Question: Give a one-sentence summary of this figure.
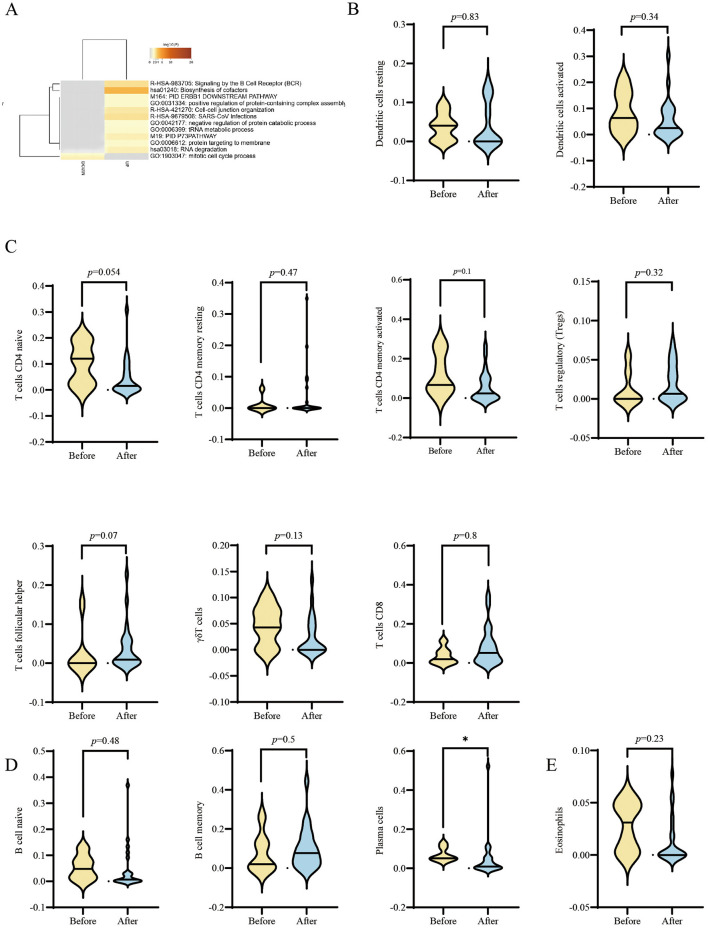
Answer: Exploratory immunomodulatory analyses of MSC-EVs. (A) Heat map of significantly altered pathways before and after 3D-EVs treatment in PBMCs (FDR, P < 0.05). (B–E) Immunophenotyping of PBMCs. Results are shown as violin plots for the distribution and change in each of the parameter studied. The median is represented by a bold dashed line. P values, by Wilcoxon test, display the levels of significance between before and after treatment. * P < 0.05.